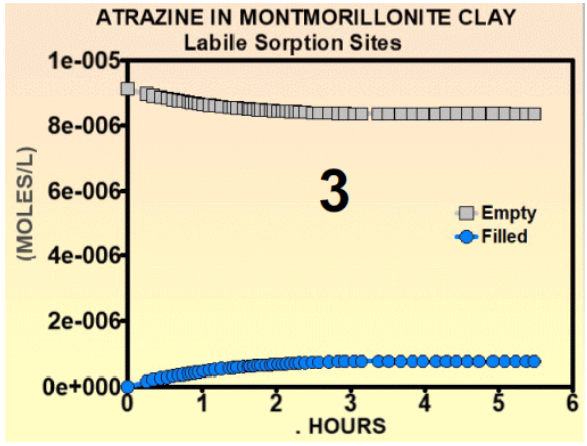
Figure 3. Atrazine in a suspension of sodium montmorillonite 25.0 °C. Empty and filled sorption sites with solution concentration define the stoichiometry.